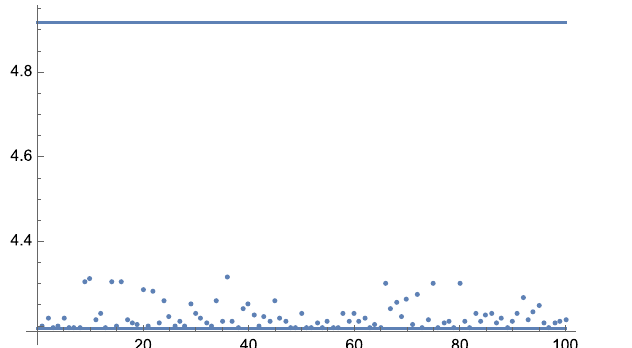
Fig. 18 The variances V [ F ] of Example 6 computed for 100 independent executions with the linear heuristic and using the second technique of Sect. 5.1 to sort out negative solutions. We use the same 100 samples from each technique as in Fig. 16. The horizontal lines correspond to the optimal and the equal sampling budget variances, respectively. Compare it with Figs. 16 and